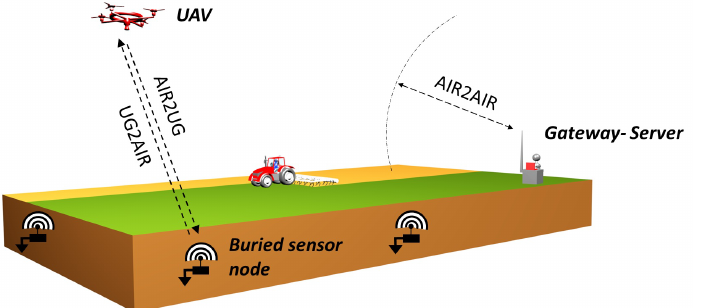
Figure 1. Environmental monitoring system is based on a set of sensor nodes distributed underground. Periodically, the UAV collects the data by following an optimized flight trajectory. The data are delivered to the remote gateway at the end of the